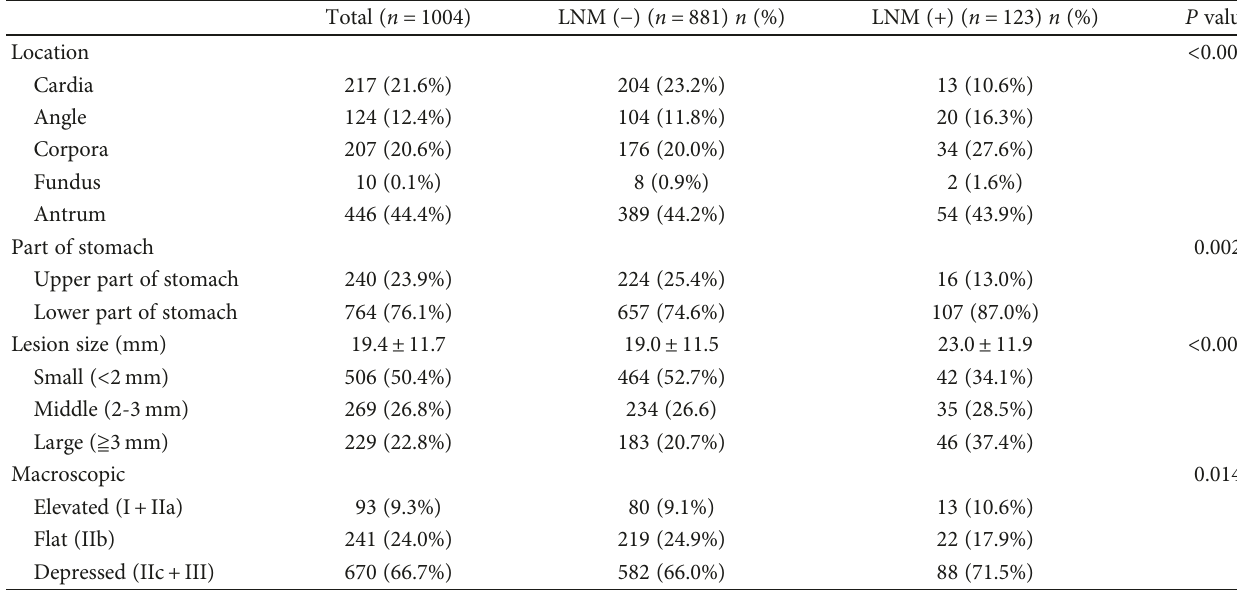
Table 2: Endoscopic features of the included